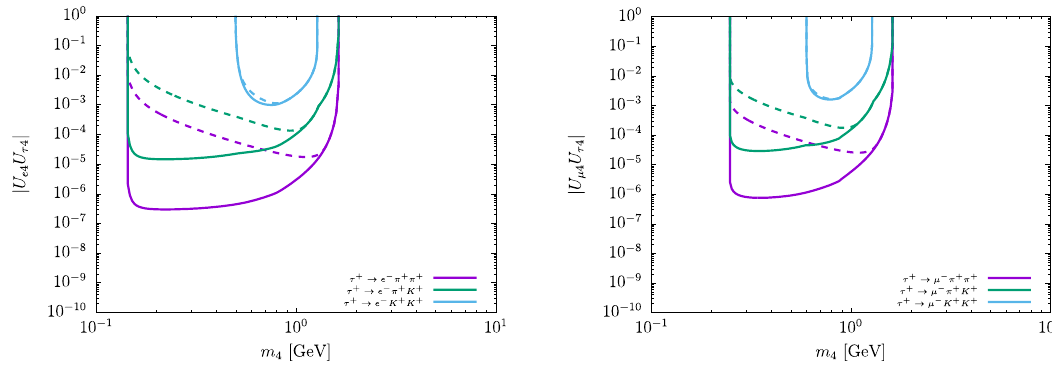
Figure 5 . Updated constraints on the relevant combination of leptonic mixing matrix elements ( j U ‘ U (cid:28) 4 j ) arising from LNV semileptonic tau decays, as a function of the heavy sterile neutrino (cid:11) 4 mass (GeV). Same assumptions on U ‘ as leading to (cid:12)gure 3. Dashed lines denote the bounds (cid:11) 4 . 10 m. derived under the requirement L (cid:13)ight (cid:23) 4